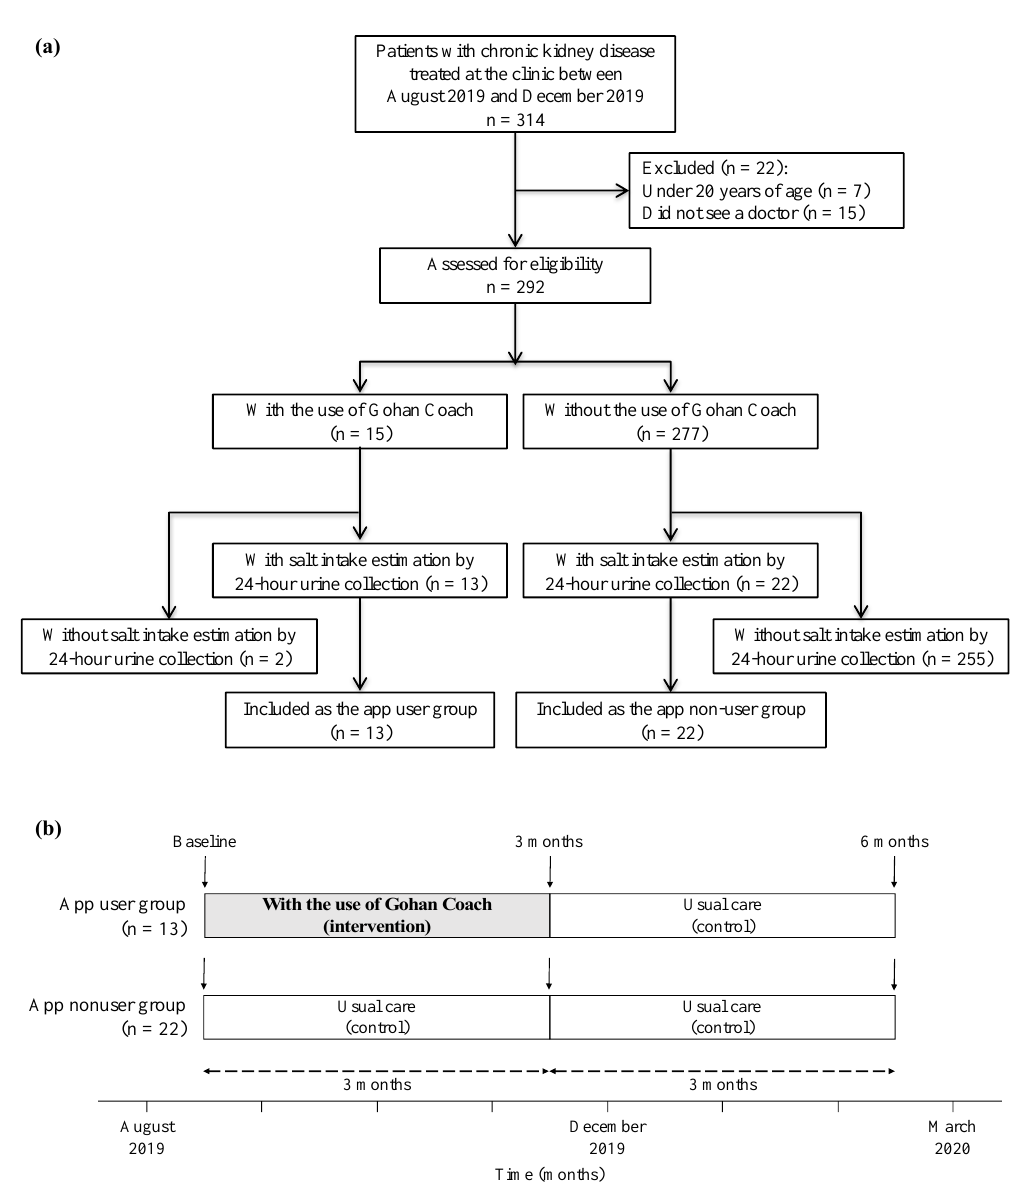
Figure 1. The flowchart of ( a ) the recruitment process and ( b ) the study process.